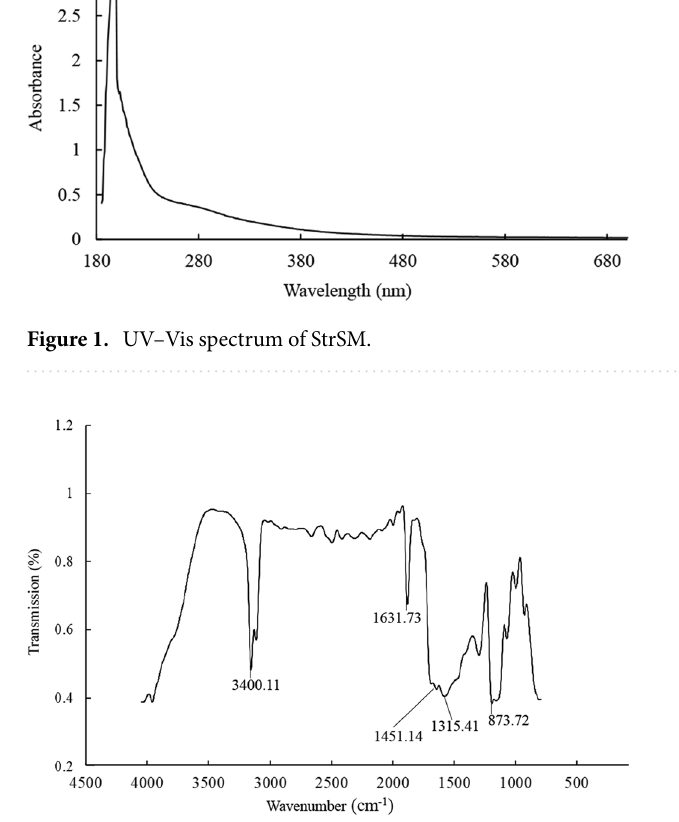
Figure 2. FTIR of spectrum of